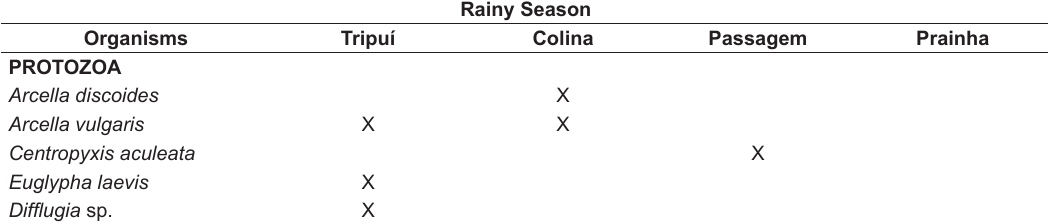
Table 3. Presence of zooplanktonic species in the sampled points for the rainy